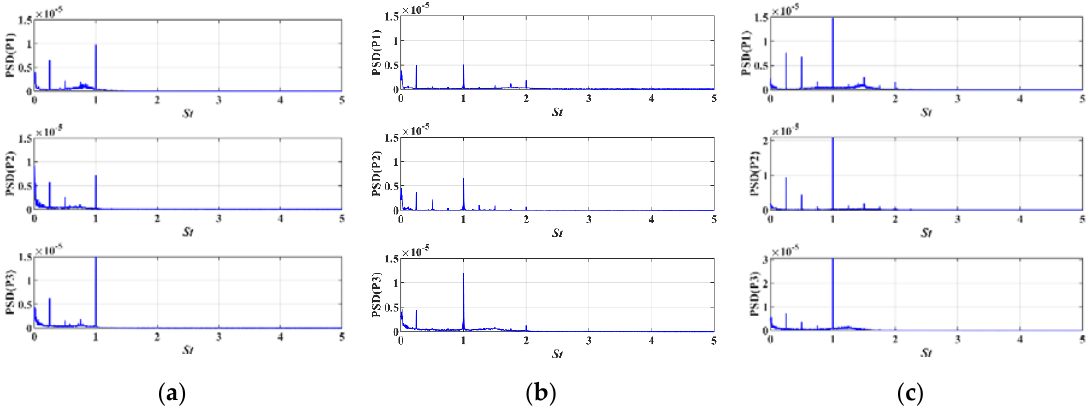
Figure 10. Frequency domain of pressure pulsations for three schemes at H min = 3.5 m: ( a ) H = 204 mm; ( b ) H = 164 mm; ( c ) H = 142 mm.